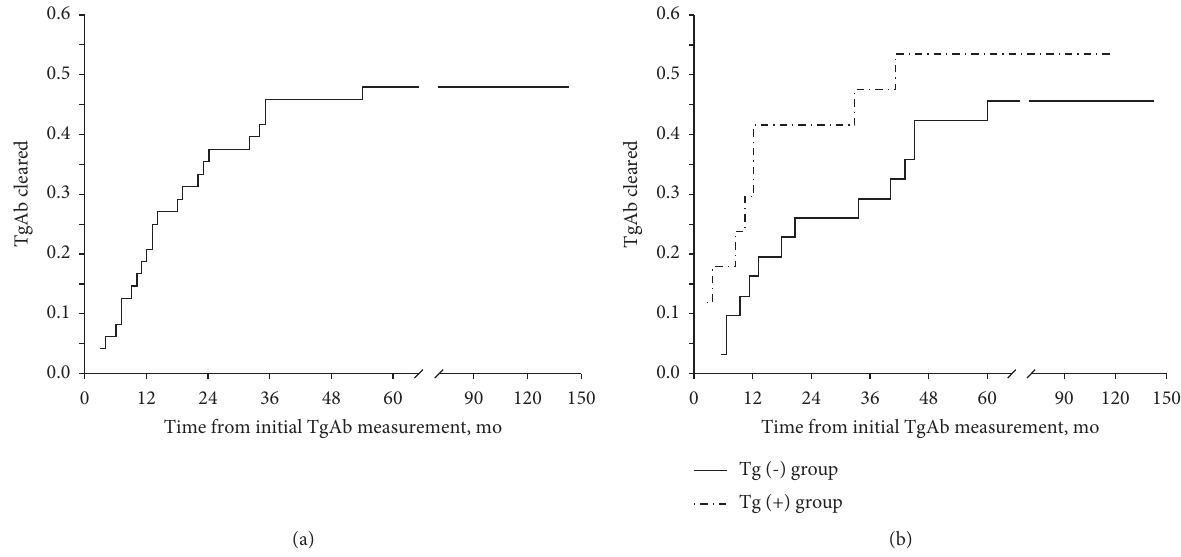
Figure 1: (a) Clearance of TgAb after initial treatment in pediatric patients with PTC. (b) Clearance of TgAb after initial treatment in pediatric patients with PTC in the P-Tg and N-Tg